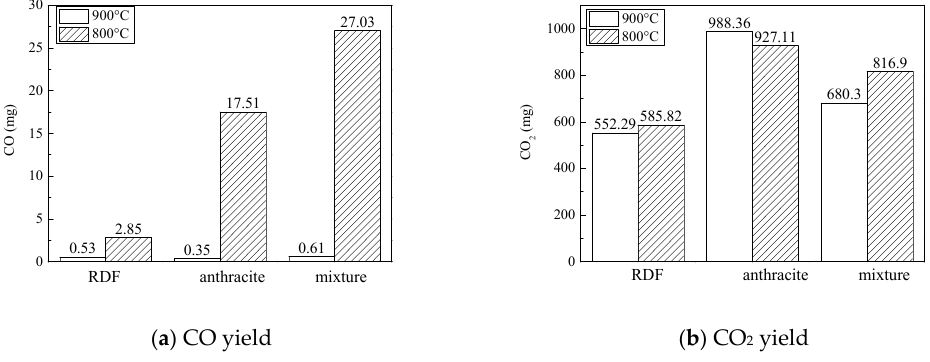
Figure 5. CO and CO 2 emission yield at different temperatures.